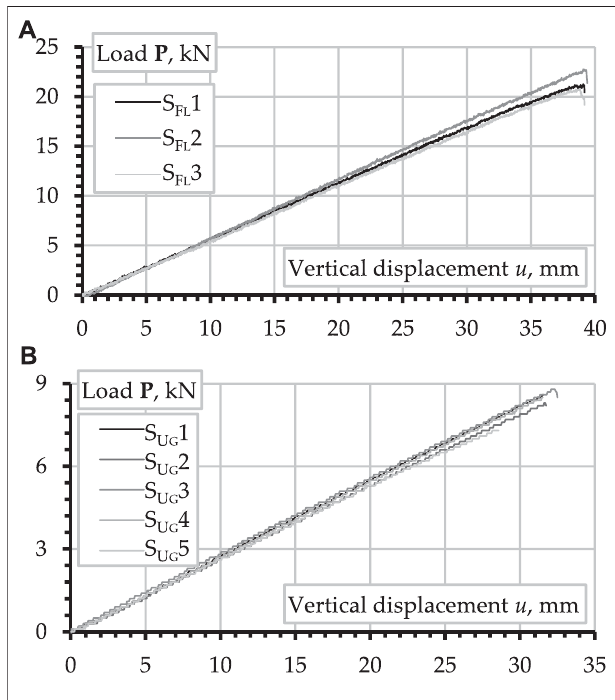
FIGURE 8 | Three-point bending test results: (A) F IBERLINE pro fi les; (B) U GIRA